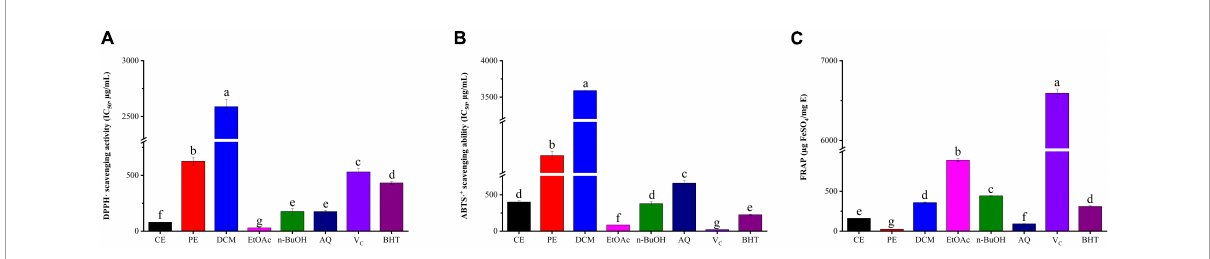
FIGURE1 The antioxidant activity of BCF crude extract and its fractions. (A) DPPH · scavenging assay, (B) ABTS · + scavenging assay, (C) ferric reducing antioxidant power (FRAP), CE, crude extract; PE, Petroleum ether fraction; DCM, Dichloromethane fraction; EtOAc, ethyl acetate fraction; n-BuOH, n-Butanol fraction; AQ, aqueous phase residue. The columns with different letters represent a significant difference at p < 0.05.